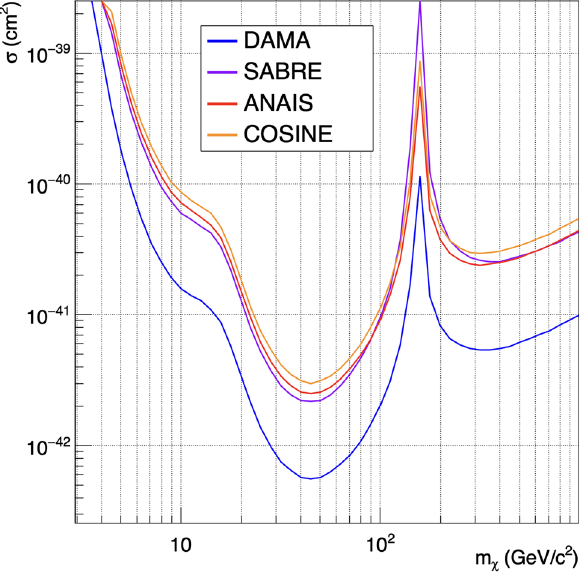
Fig. 4 90% C.L. modulation sensitivity of various NaI detectors by 2025, assumingallthreearecontinuouslytakingdata.Weassumeaspin independent elastic WIMP. For each detector the exposure mass and R b are shown in Table 1. The total live time assumed for each detector by 2025 is 18 years (DAMA), 9 years (COSINE), 8 years (ANAIS), and 3 years (SABRE)